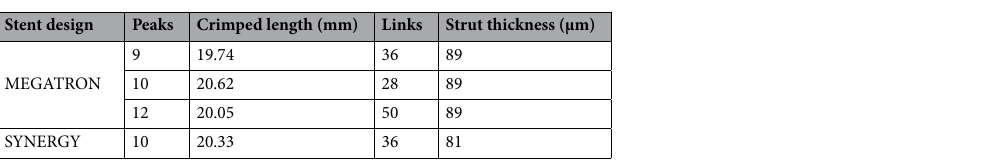
Table 2. Characteristics of different stent